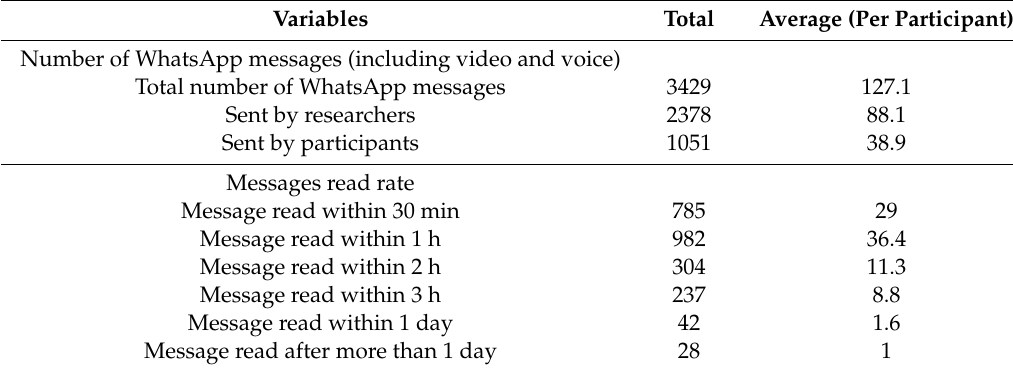
Table 4. Use of digital